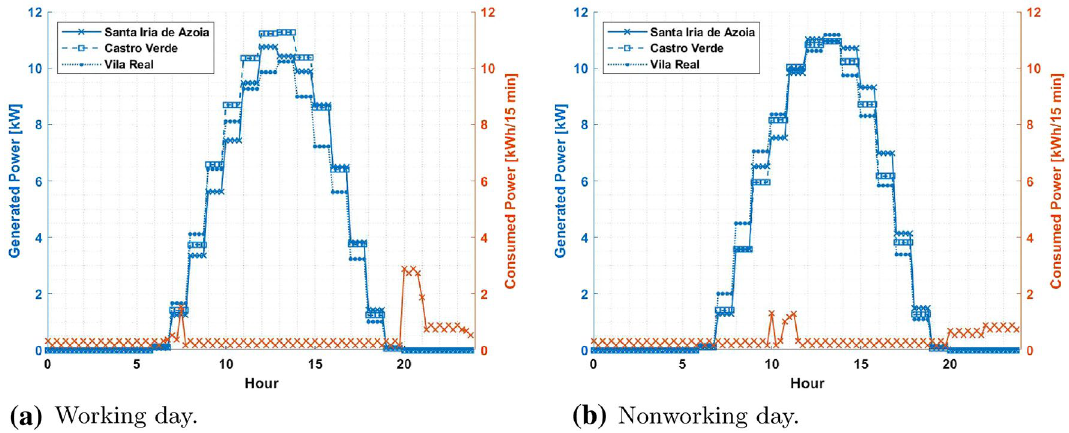
Fig. 14 Generation and consumption curves on the two significant days of August for CIGS technology